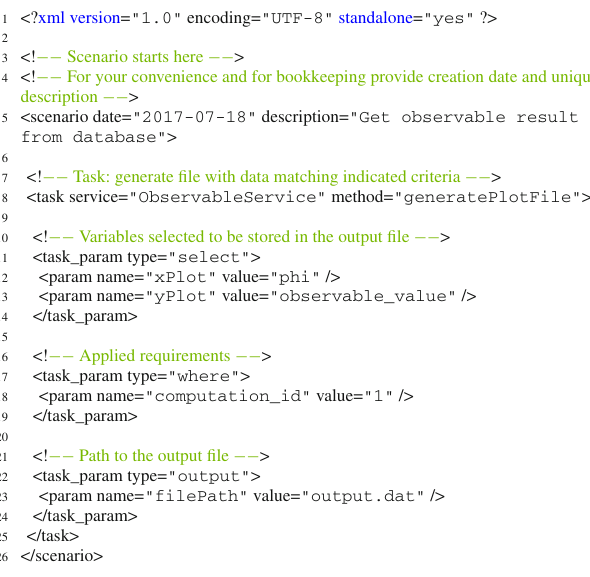
Fig. 9 Beam spin asymmetry A − Q 2 = 4 GeV 2 , and E Lab = 11 GeV. Compton Form Factors are eval- uated at LO approximation with the GK GPD model